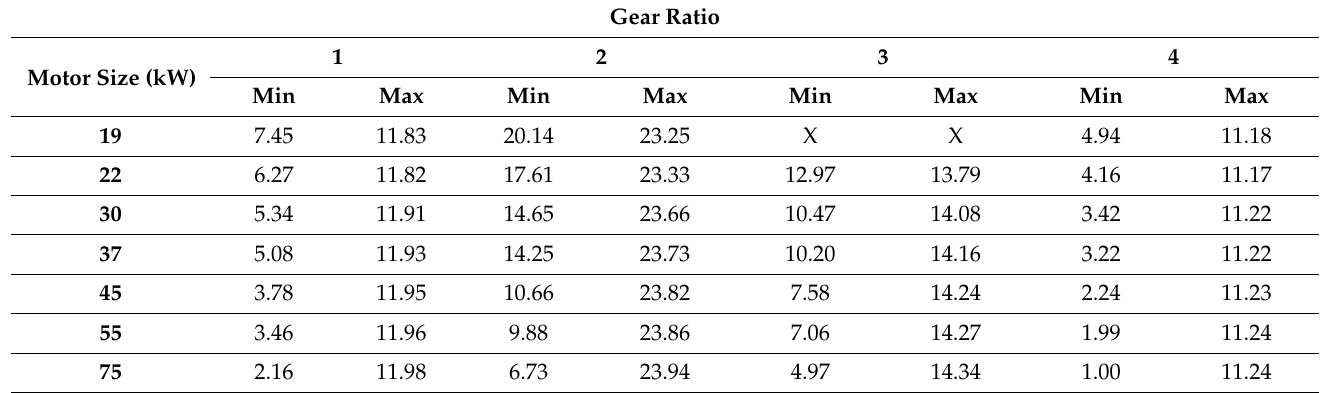
Table 5 . Gear ratio ranges applicable for all AC motors.